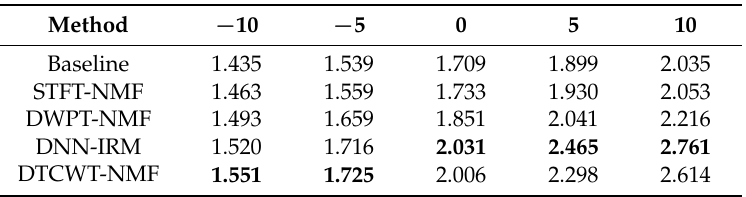
Table 3. The PESQ values under five SNR cases.